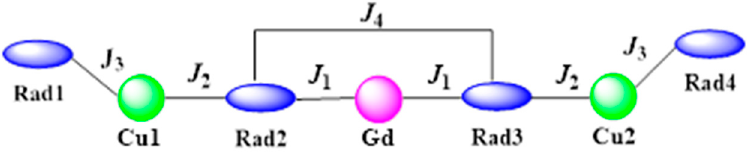
Scheme 4. Magnetic coupling pathways in complex 2